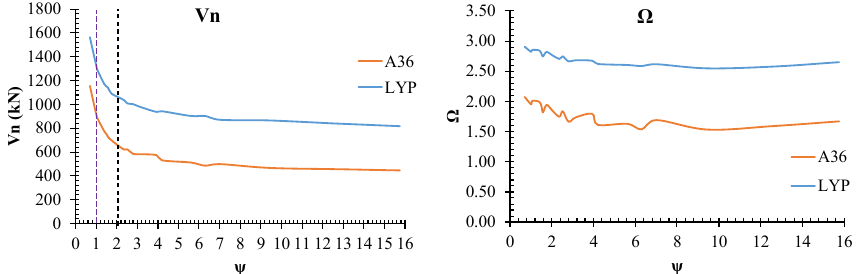
Figure 12. The Ω and Vn versus ψ for LYP and A36 dampers.